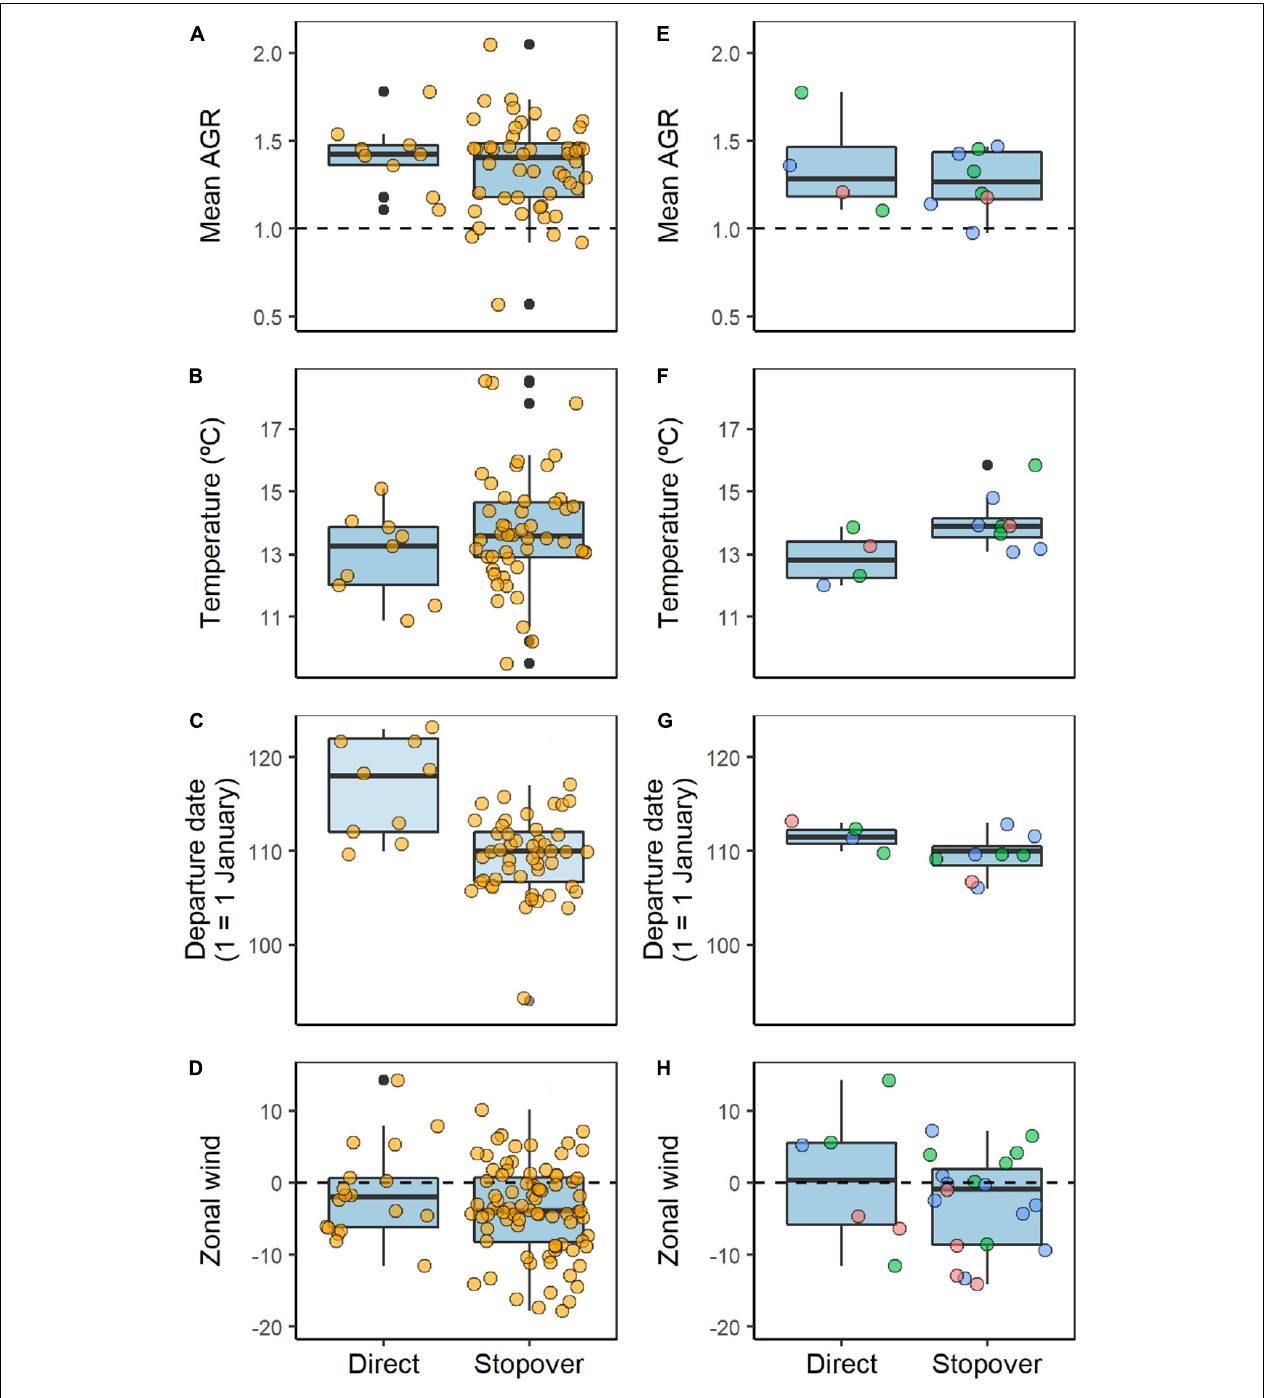
FIGURE 2 | Variation in potential drivers of spring migratory behavior (direct vs. stopover) of Icelandic whimbrels at the population (left column; A–D ; n = 9 direct and 48 stopover migrations), and individual levels (right column, E–H ). The three individuals that changed spring migratory behavior between years (right column) are coded by color. (A,E) Mean individual air-to-ground speed ratio (AGR) from departure up to latitude 42 ◦ N (values below one represent wind support, while values above one mean impediment in the direction of movement). (B,F) Air temperature experienced by each individual at latitude 42 ◦ N. (C,G) Departure date from the wintering site. (D,H) Zonal wind (u) component, (ms − 1 ) between 37 and 50 ◦ N, where negative values represent westward winds and positive values eastward winds (note that between those latitudes the number of locations per track can be more than one, hence the number of locations is higher than the number of migrations; n = 18 for direct and n = 80 for stopover migrations). All data refers to air pressure 1,000 hPa (i.e., 111 m a. s. l.). Boxplots show the median and 25 and 75% quartiles, whiskers extending up to 1.5 times the inter quartile range from the median and points beyond that are individually marked in black.